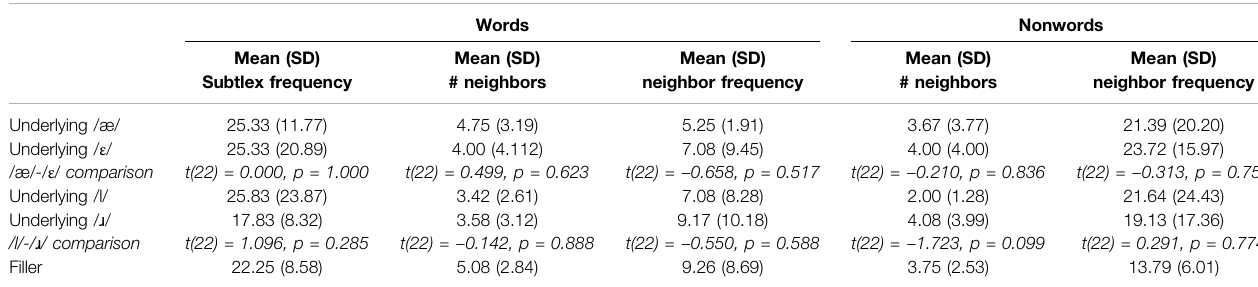
TABLE 4 | Lexical characteristics of the /æ/-/ ε / and /l/-/ ɹ / stimulus sets. Words